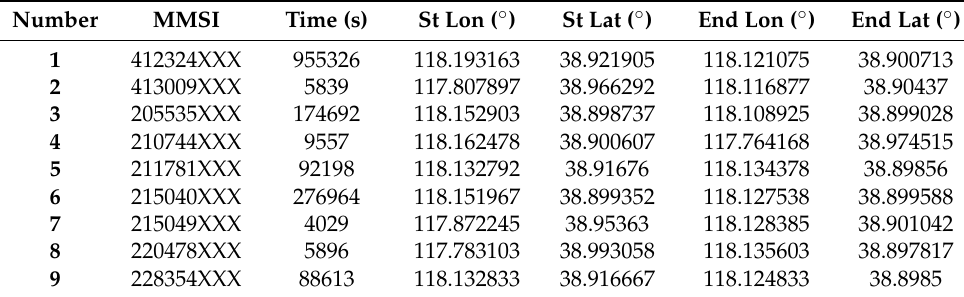
Figure 13. AIS big data in Tianjin Port. Table 3. Information of target ships.